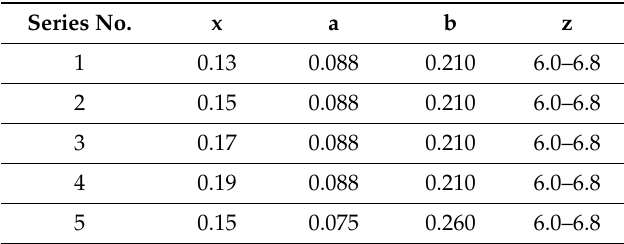
Table 1. Chemical compositions of experimental Sm 1-X Zr X (Co 1-a-b Cu a Fe b )z alloys (x, a, and b are atomic